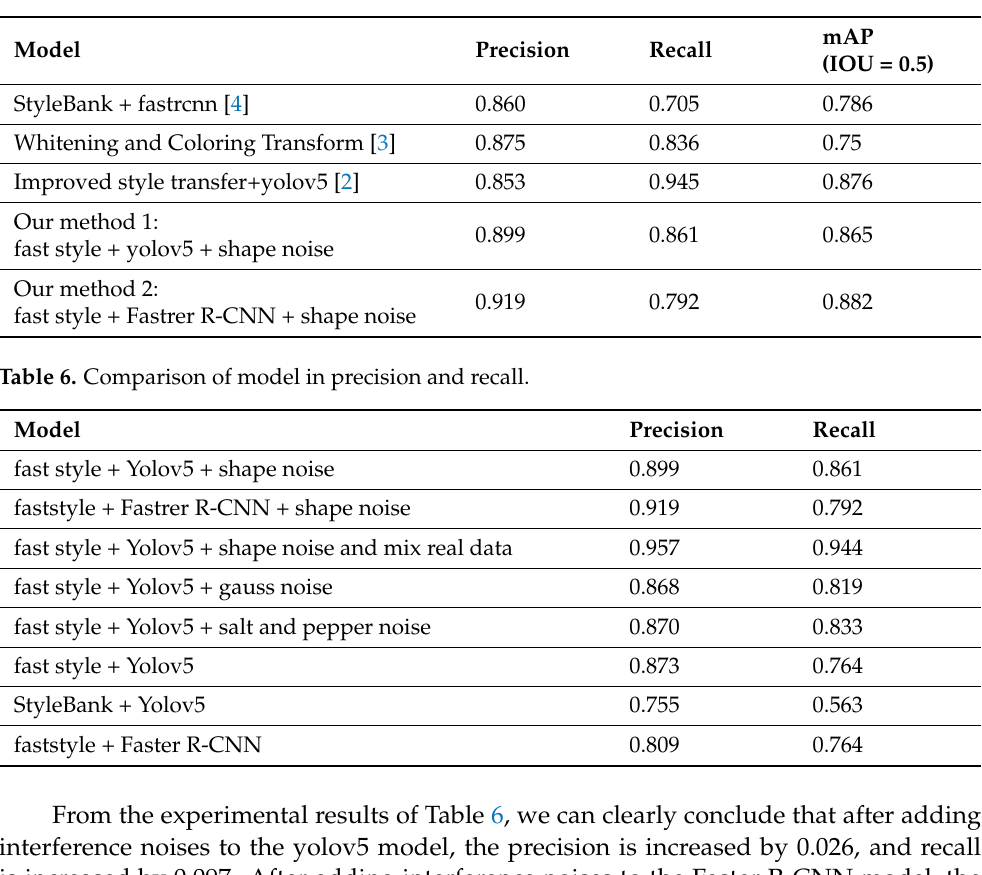
Table 5. Comparison on existing methods performance.